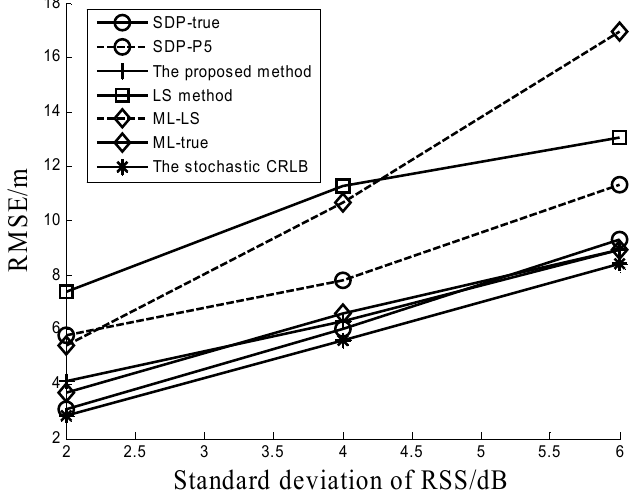
Figure 1. Performance comparison under different RSS noises.